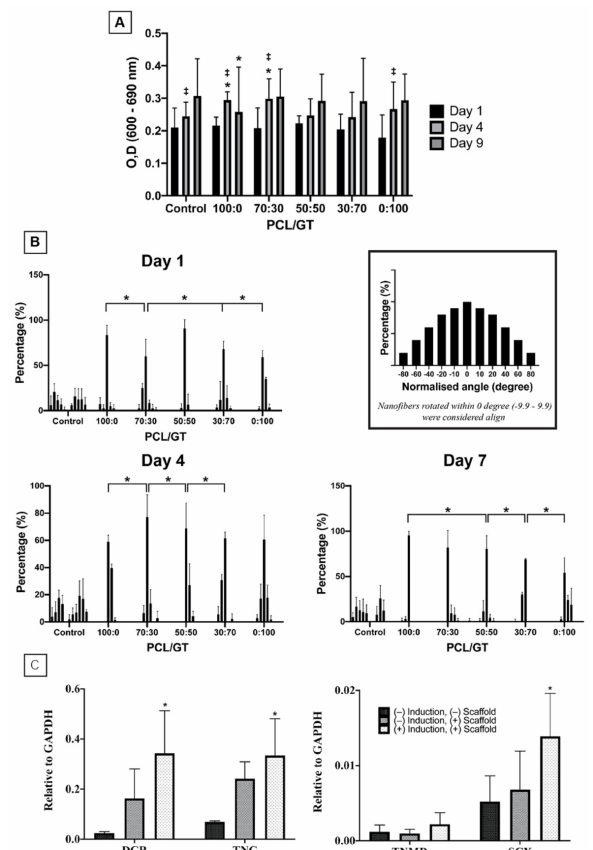
Figure 5. ( A ) Viability of WJ-MSCs cultured on PCL/GT nanofibers. Overall, WJ-MSCs were viable for 7 days in culture with PCL/GT nanofibers. Two-way ANOVA with post-hoc Tukey or Dunnett’s test was used for analysis. ‡ p -value (<0.05) compared to day 1 within each group. * p -value (<0.05) compared to control within each day (1, 4 and 9). ( B ) Alignment of WJ-MSCs on PCL/GT nanofibers. * p -value (<0.05). ( C ) Tenogenic gene expression of WJ-MSC in culture with PCL/GT nanofibers that includes decorin (DCR), tenascin-C (TNC), scleraxis (SCX) and tenomodulin